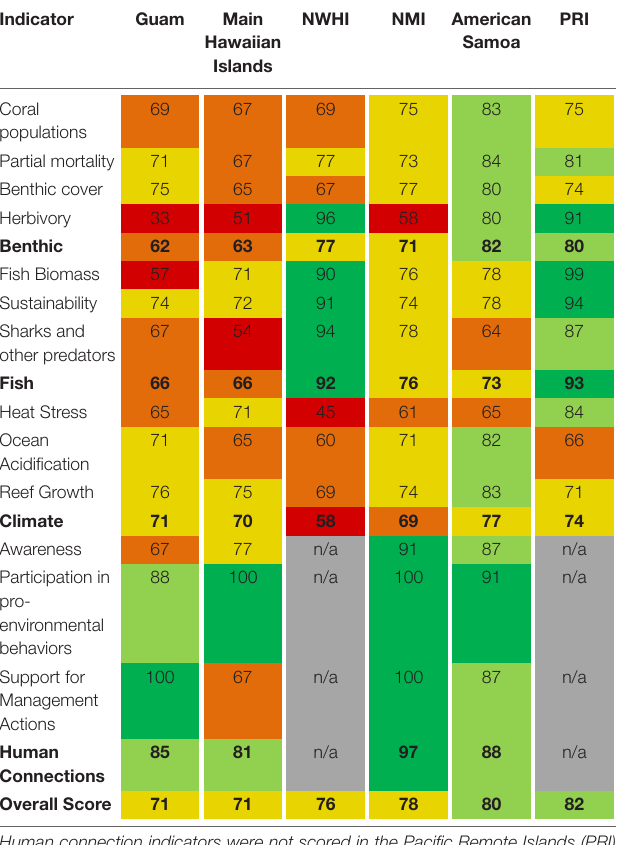
Colors refer to scoring bins described in the methods section with dark green representing Very good, light green representing Good, yellow representing Fair, orange representing Impaired, and red representing